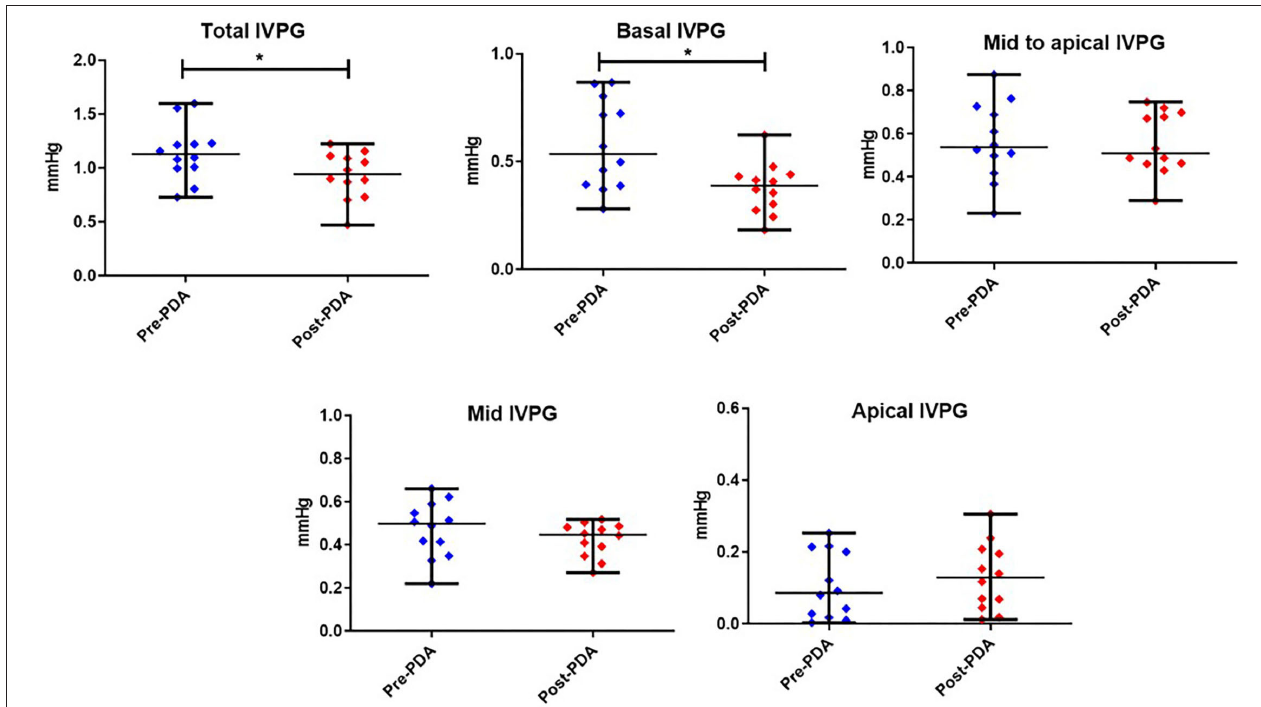
FIGURE 4 | Dots plots showing the median and range of the intraventricular pressure gradients (IVPG) indices Pre-and Post-PDA closure in dogs ( n = 12). *reveals the statistical significance ( P < 0.05).